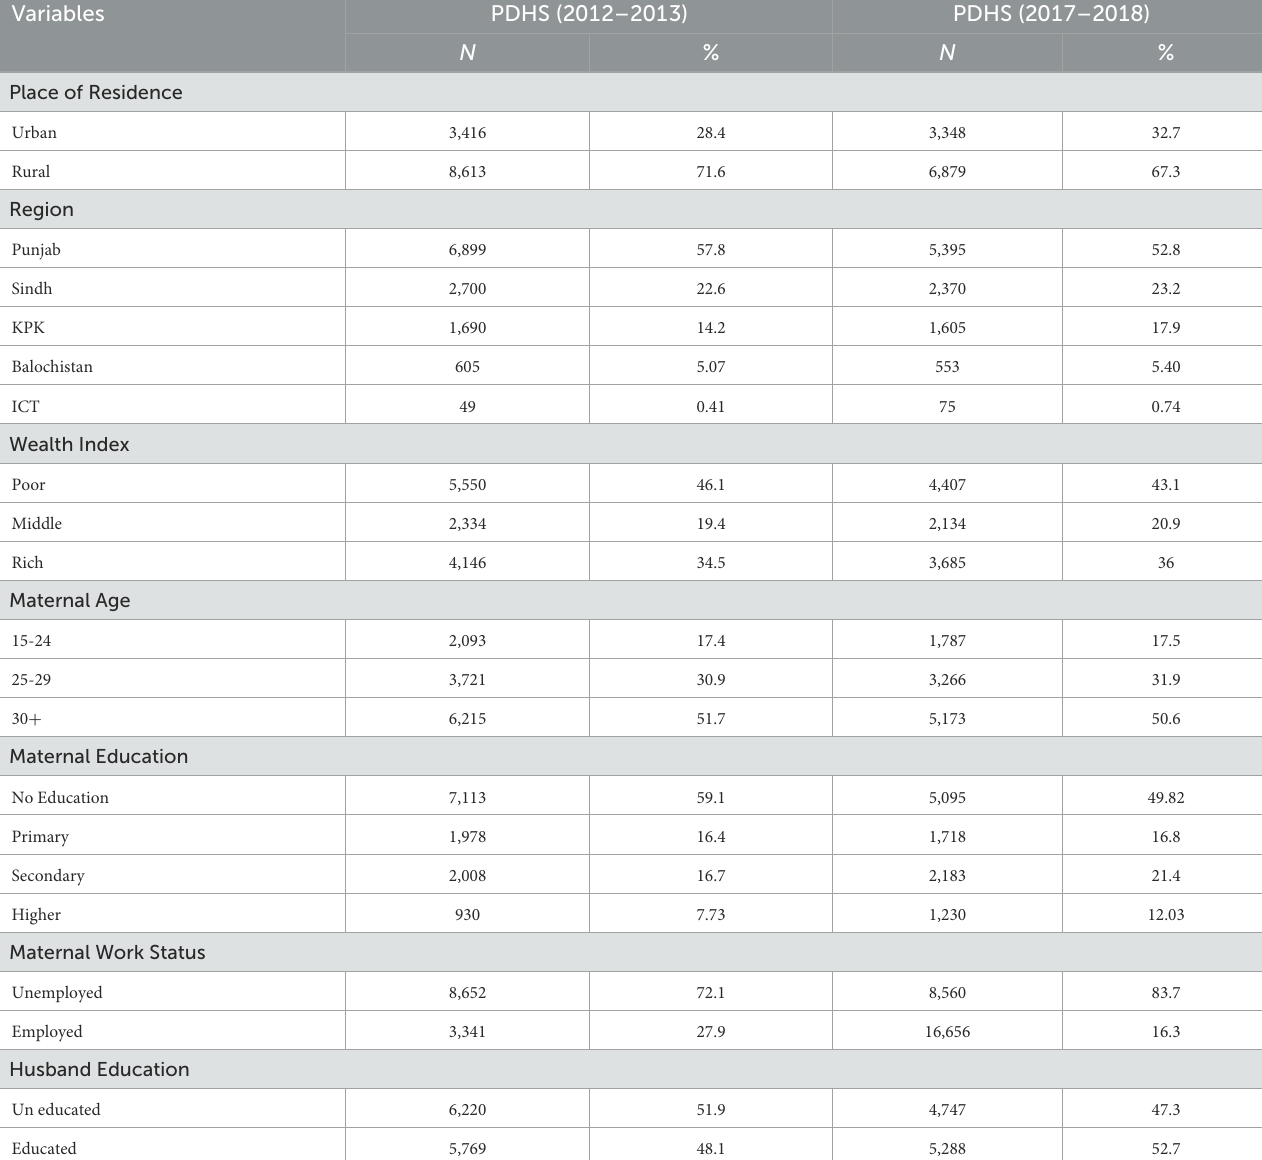
TABLE 1 Sociodemographic characteristics of ever married women who had given birth within 5 years before survey in Pakistan, PDHS from 2012 to 2013 and from 2017 to 2018.